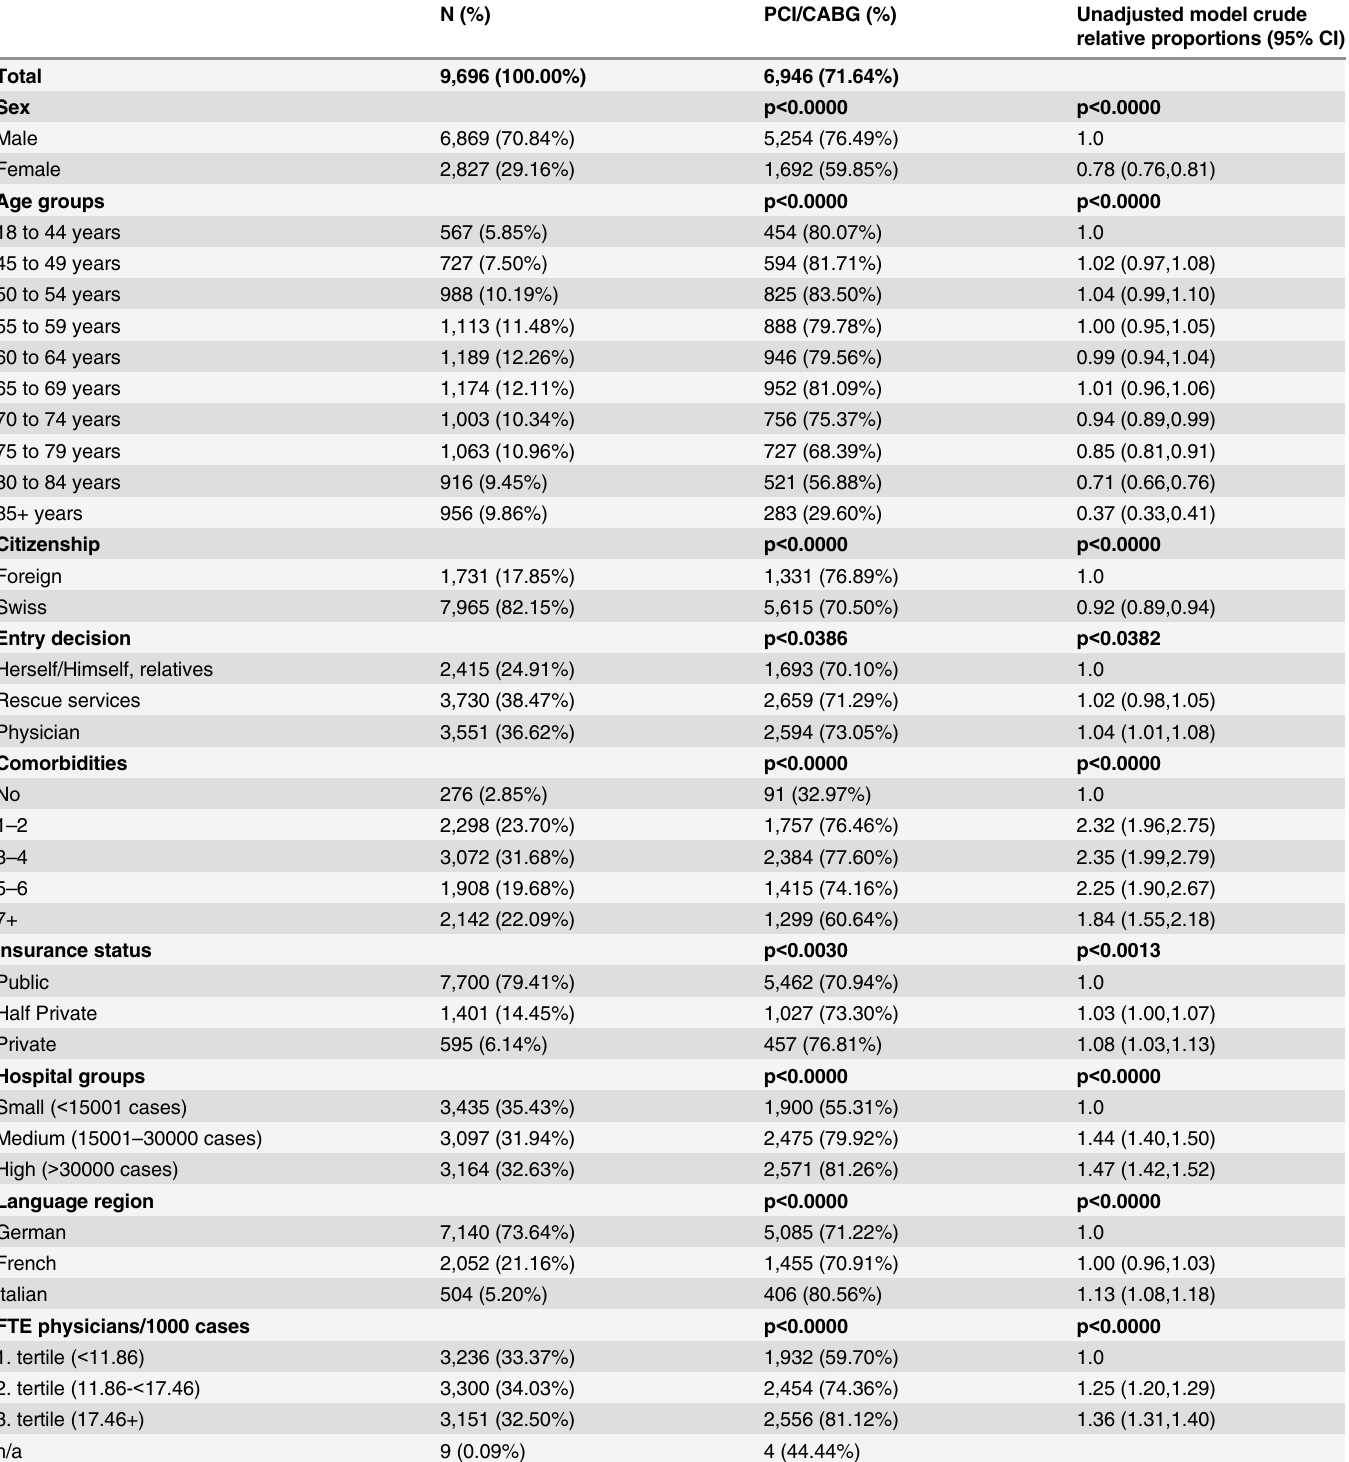
Table 1. Socio-demographic, socioeconomic and healthcare-related factors of the study population and crude rates of receiving a revasculariza- tion, Switzerland 2010 –